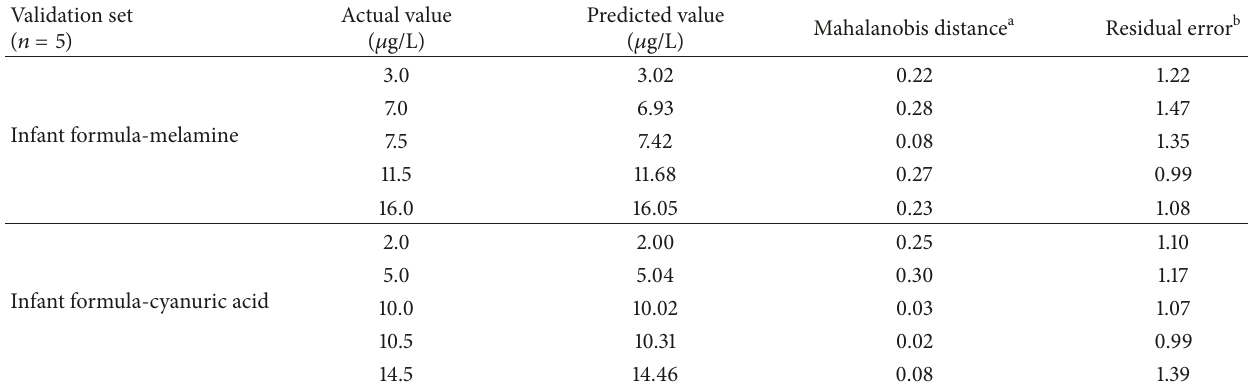
Table 2: External validation data of the PLS1 chemometric models.